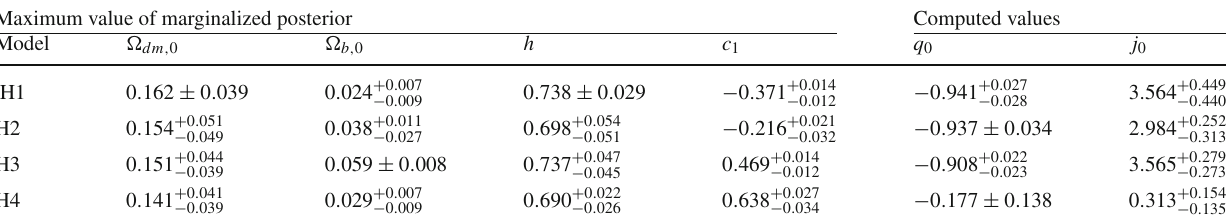
Table 5 The maximum value of marginalized posterior for each of the parameters of HDE models (left part) and the value of cosmographic parameters calculated upon maximum of the marginalized posterior (right part). We note that in these models we have L = H − 1 as IR cutoff Maximum value of marginalized